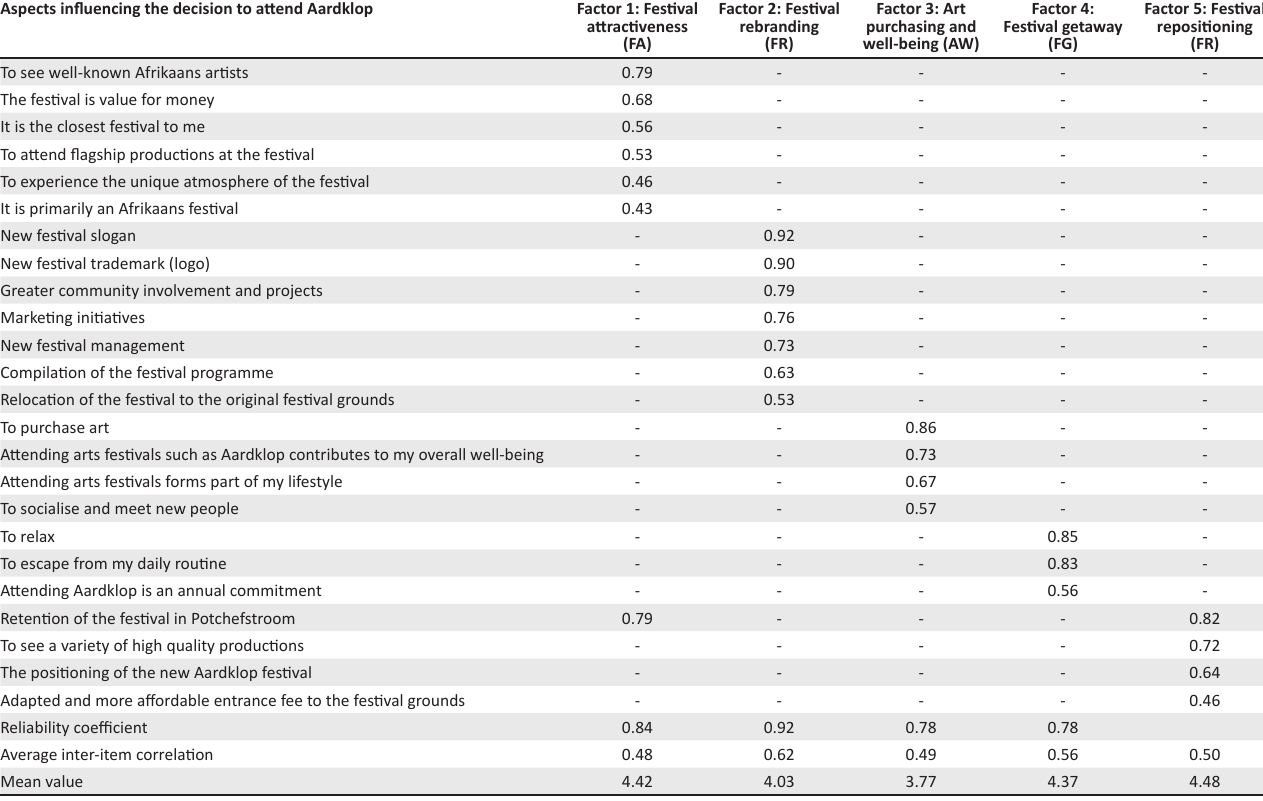
TABLE 2: Results from the factor analysis regarding the influential decision-making factors to attend the festival. Aspects influencing the decision to attend Aardklop Factor 2: Festival